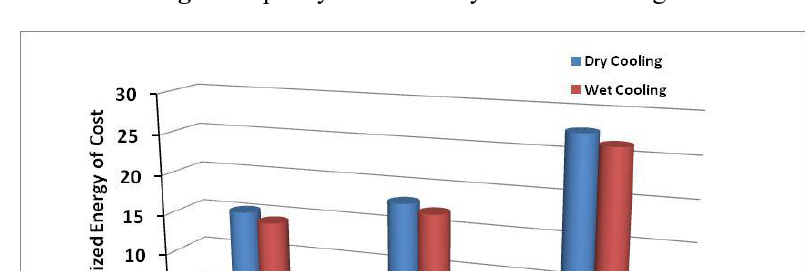
Fig. 8. Capacity factor for dry and wet cooling.